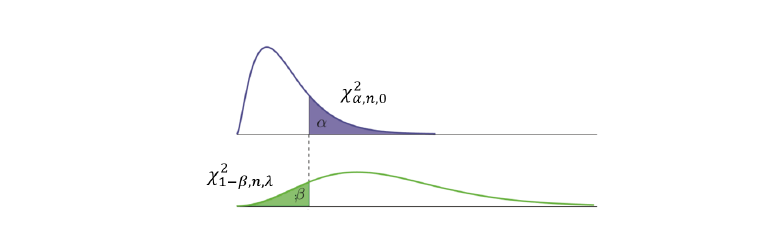
Figure 2. Central (top) and non-central (bottom) Chi-square distribution of test-statistic under null and alternative hypothesis respectively: false alarm (type I error) probability α and missed detection (type II error) probability β are